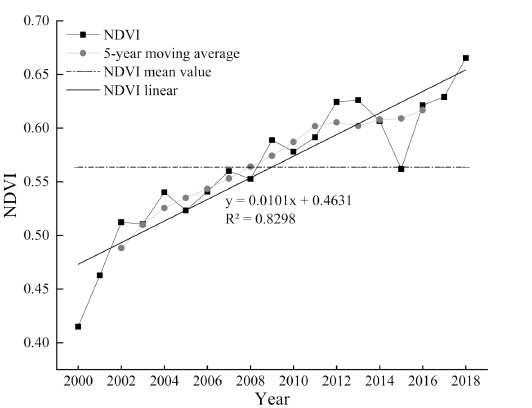
Figure 3. Trend of the mean NDVI in Northern Shaanxi from 2000 to